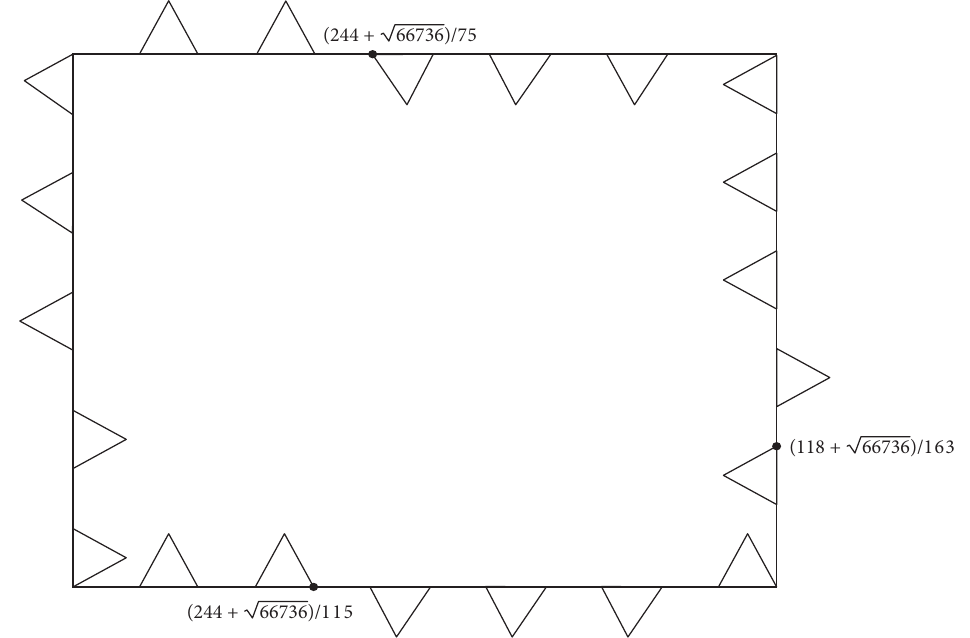
Figure 3: Shows the location of reduced numbers and describes that [ 1 , 6 , 5 , 4 , 3 , 2 ] ∼